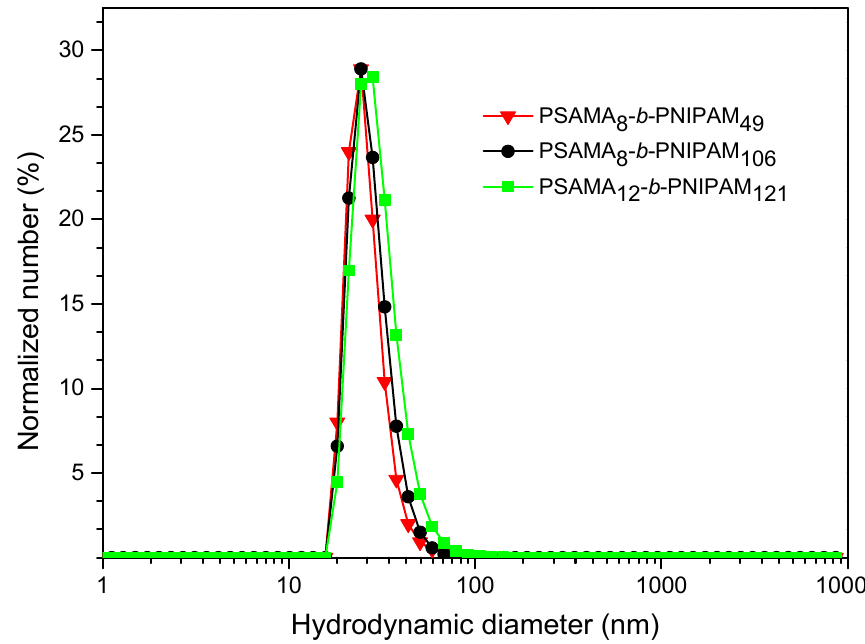
Figure 4. DLS distributions for PSAMA- b -PNIPAM in aqueous solution at 25 °C. The morphology of self-assembled block copolymer particles was further explored by TEM. As displayed in Figure 5, all the PSAMA- b -PNIPAM copolymers with different block ratios self-assembled into spherical core-shell micelles. From TEM images, the micellar sizes were observed in the approximate range of 10–40 nm. It is noteworthy that unlike individual well-dispersed spheres formed by PSAMA 8 - b -PNIPAM 106 (Figure 5A), the micelles prepared by PSAMA 12 - b -PNIPAM 121 showed some aggregation behavior (Figure 5B). This may be as a result of longer hydrophobic content, the lipophilic